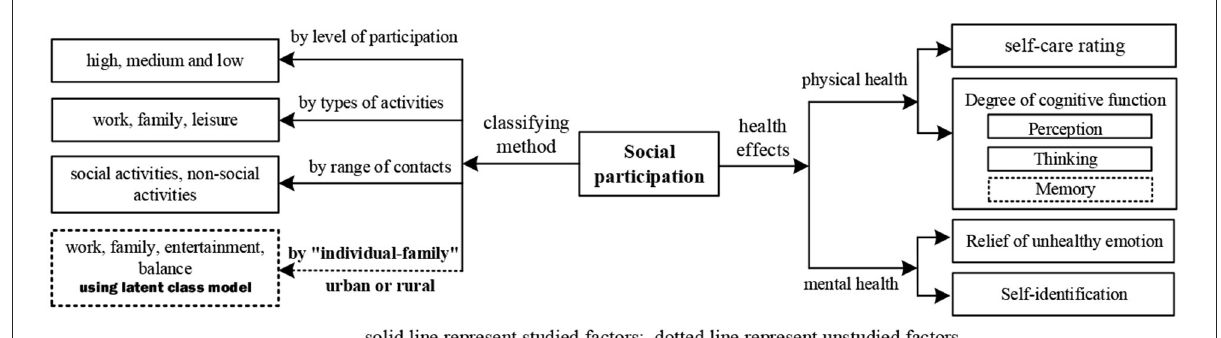
FIGURE1 Research status of social participation.